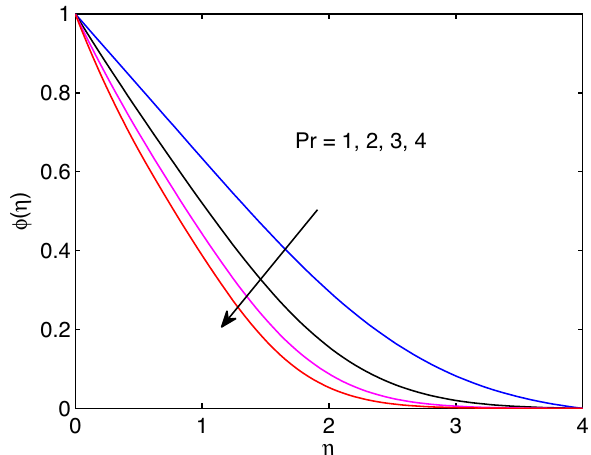
Figure 18. Prandtl number effects on volumetric concentration profiles.